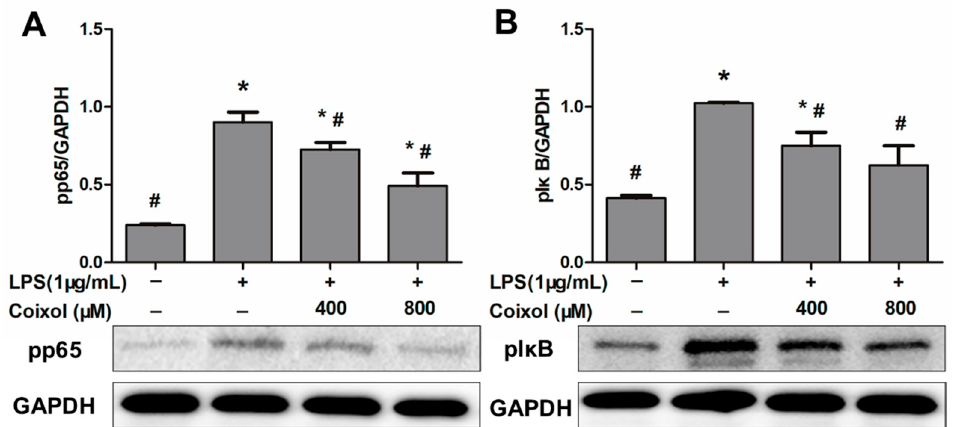
Figure 4. Effects of coixol on NF- κ B signaling activation in LPS- induced RAW 264.7 cells. Cells were pretreated with coixol for 4 h and then stimulated with 1 μ g/mL LPS for 4 h. The protein levels of ( A ) phospho (p) p65 and ( B ) pI κ B. Protein levels were measured by western blotting. GAPDH was used as internal control. The data represent the mean ± SD ( n = 3). * p < 0.05 vs. control group. # p < 0.05 vs. LPS group.